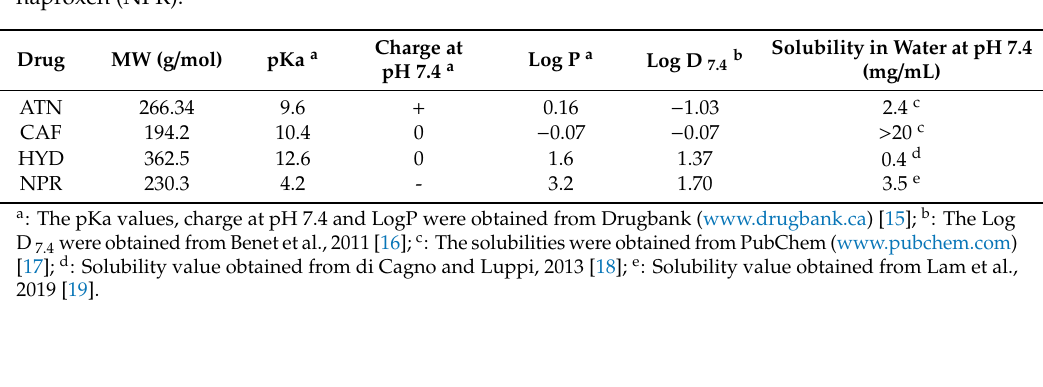
Table 1. Physicochemical characteristics of atenolol (ATN), ca ff eine (CAF), hydrocortisone (HYD,) and naproxen